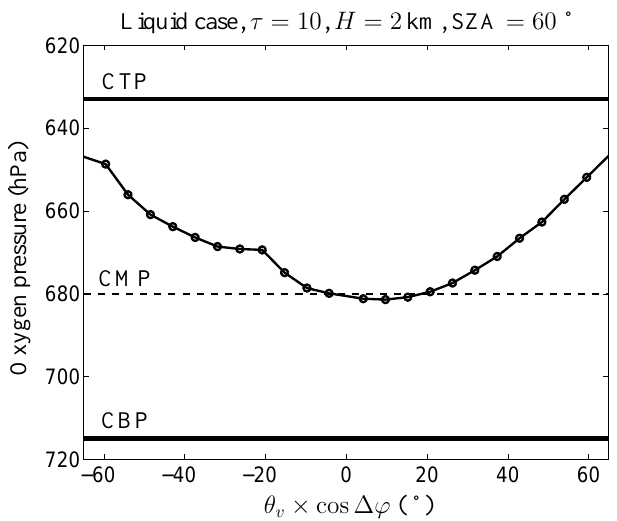
Fig. 2. Variation of simulated POLDER directional cloud oxy- gen pressure with the viewing zenith angles θ v in the solar plane ( 1ϕ is the measurement’s relative azimuth). Characteristics of the case study are indicated in the title. Horizontal lines indicate the level of cloud top, middle, and base pressures (denoted respectively by CTP, CMP, and CBP). The angularly averaged oxygen pressure is here 667hPa and the angular standard deviation 11hPa. Disconti- nuities of the directional cloud oxygen pressure at − 60 ◦ and − 20 ◦ are signatures of cloud scattering phase